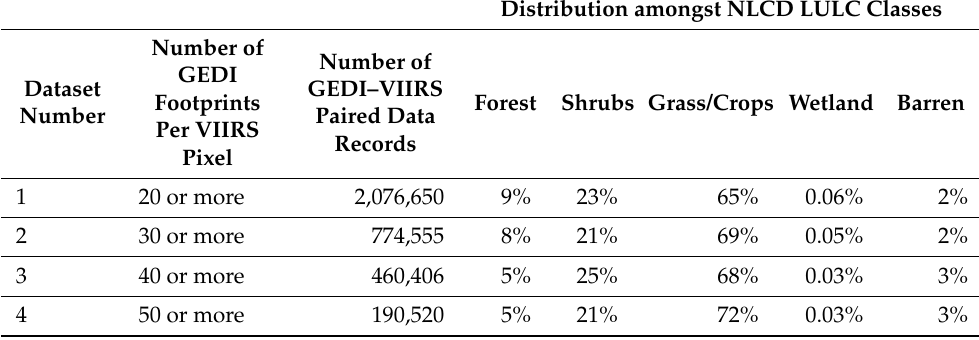
Table 5. Number of 2019 VIIRS–GEDI paired data records with 20, 30, 40, and 50 or more collocated GEDI observations and their distribution within NLCD 2016 land use and land cover classes.